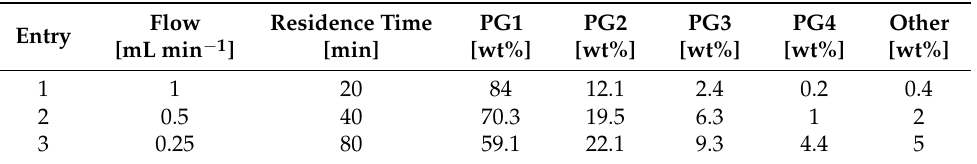
Table 1. Microwave-assisted continuous oligomerization of glycerol with peristaltic pump (gas chromatography (GC) analysis) 1 .